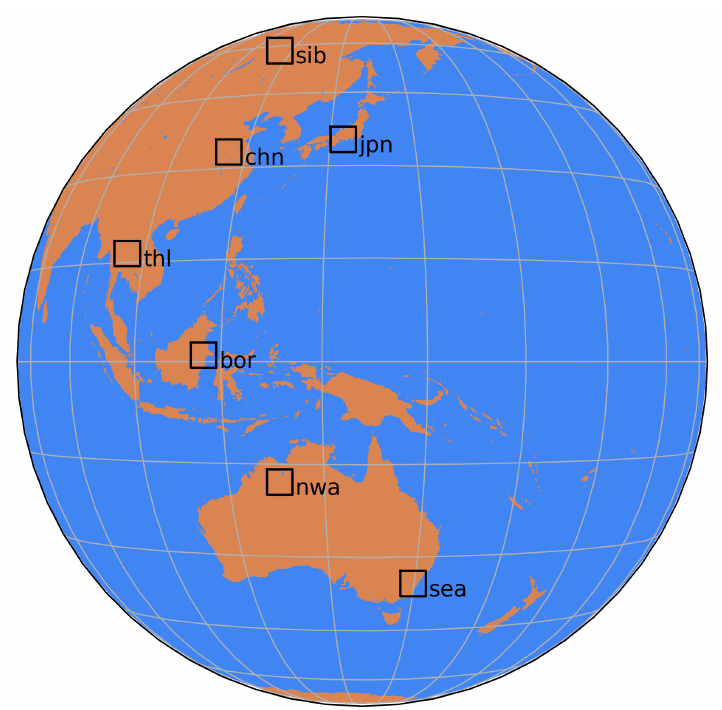
Figure 3. Case study areas selected for examination.